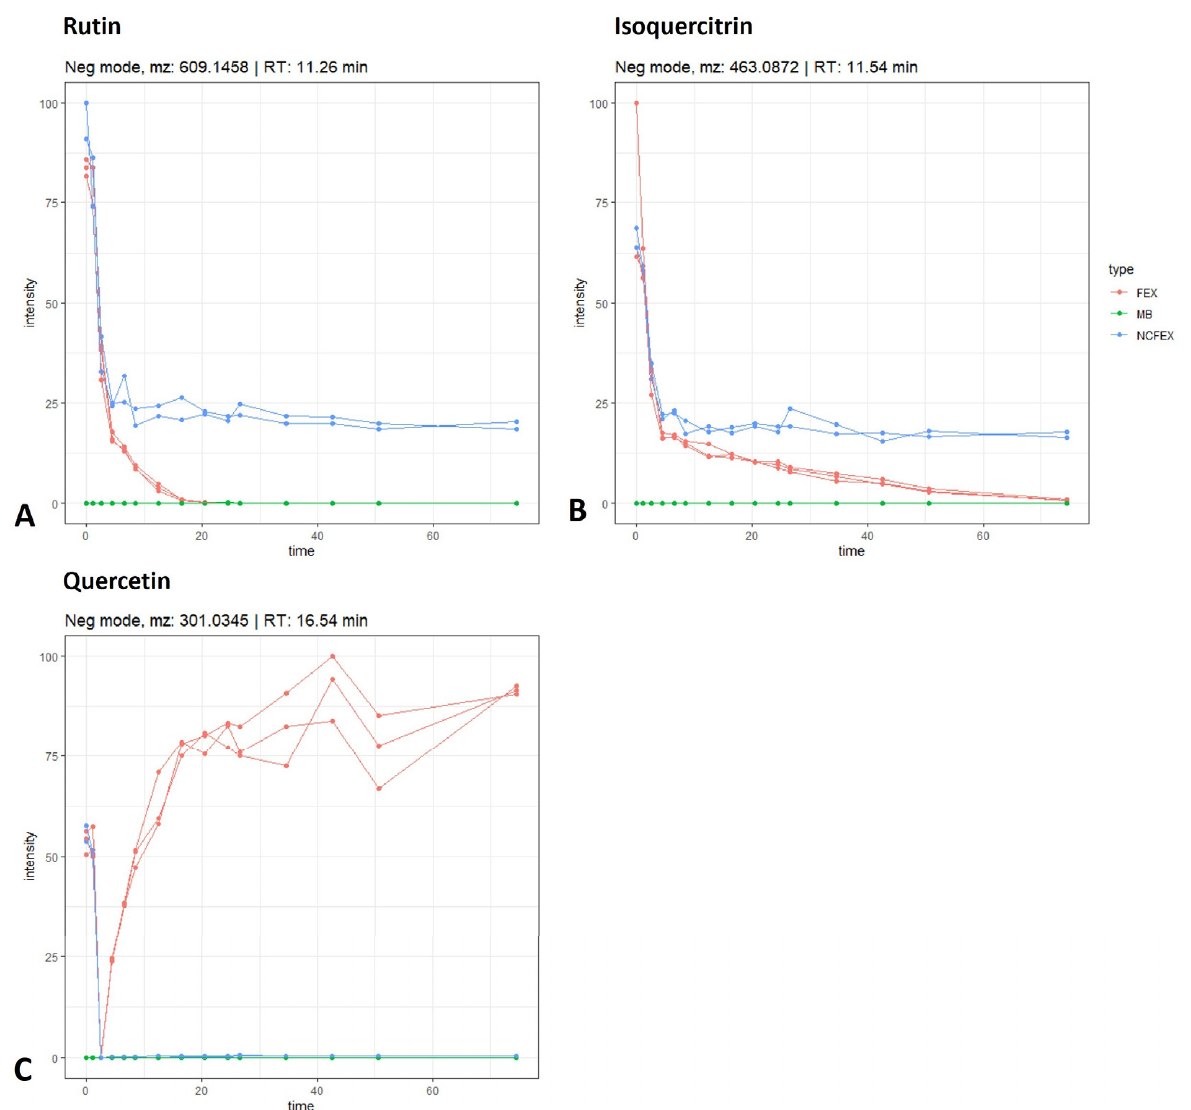
Figure 2. Time profiles (time in hours) of rutin ( A ), isoquercitrin ( B ) and quercetin ( C ) during gastrointestinal biotransformation. The gastric phase continued for 1 h, followed by the small intestinal phase for 1.5 h and a 72 h colonic phase. FEX (i.e., F. ulmaria extract) in red, NCFEX (i.e., nega- tive control) in blue and MB (i.e., method blank) in green.